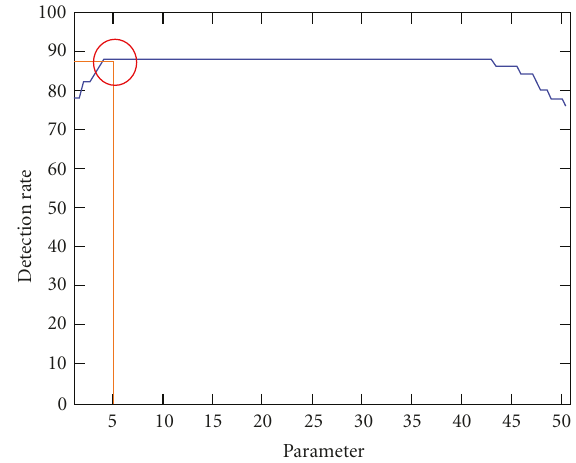
Figure 13: The detection rate with respect to di ff erent j of the covariance